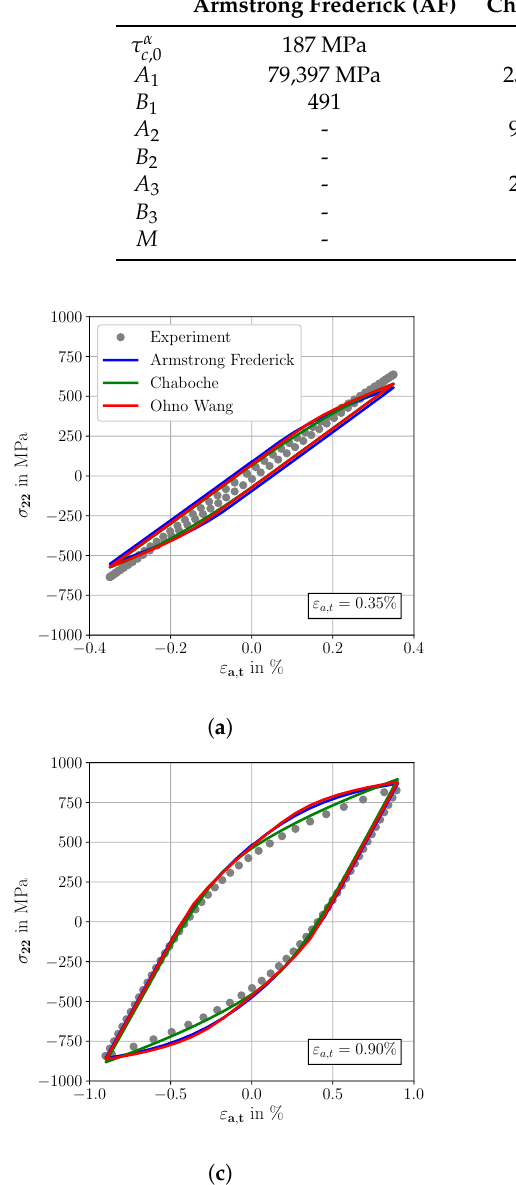
Figure 11. Experimental and simulated stress-strain hysteresis loops of SAE 4150 at cyclic stable material conditions, for three different total strain amplitudes, ( a ) ε a , t = 0.35%, ( b ) ε a , t = 0.60% and ( c ) ε a , t =